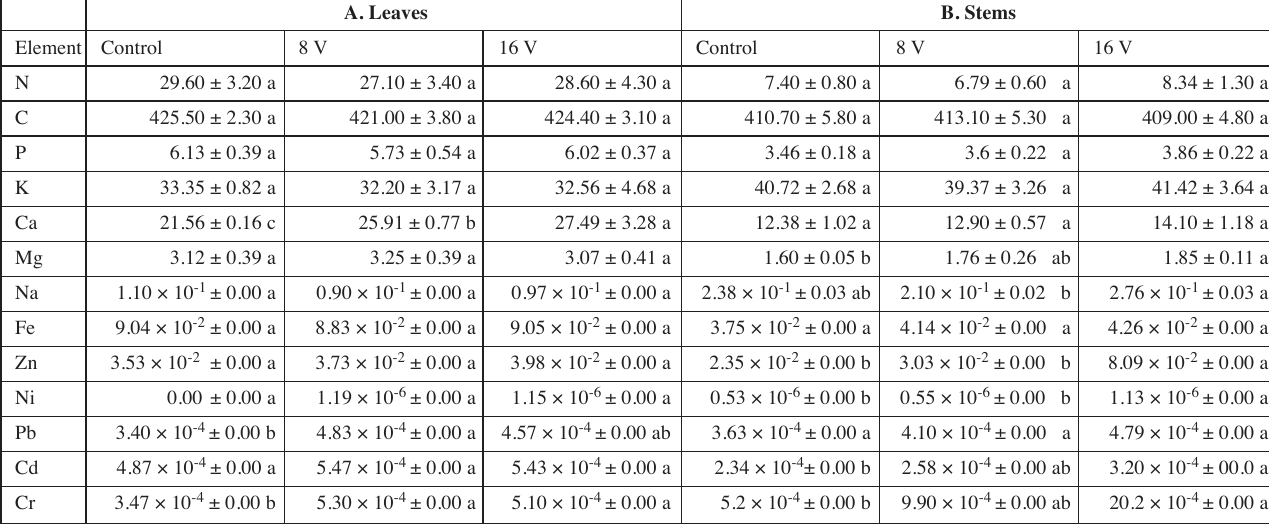
Tab. 3: Effect of voltage applications on mineral element and heavy metal content (g/kg DM) of African nightshade